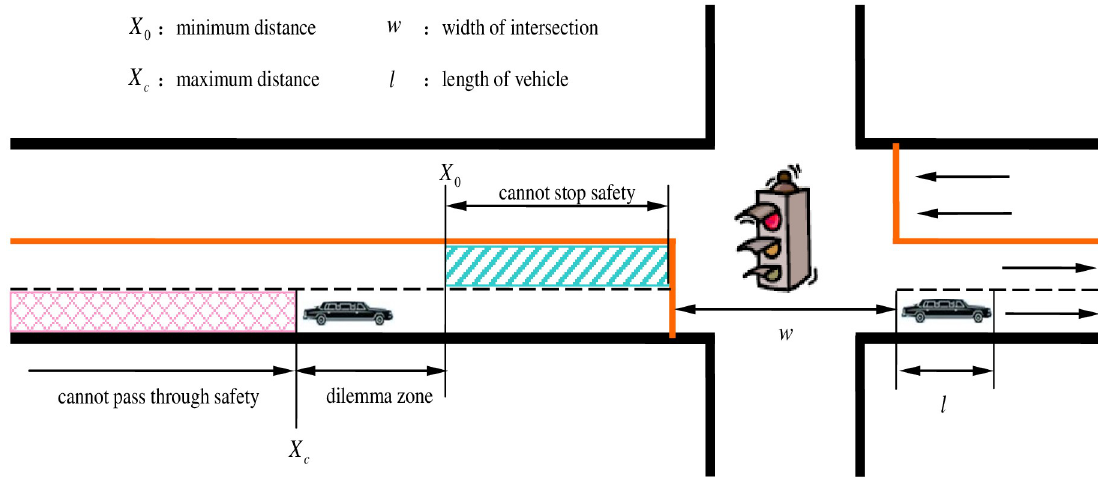
Fig 5. Type II dilemma zone.